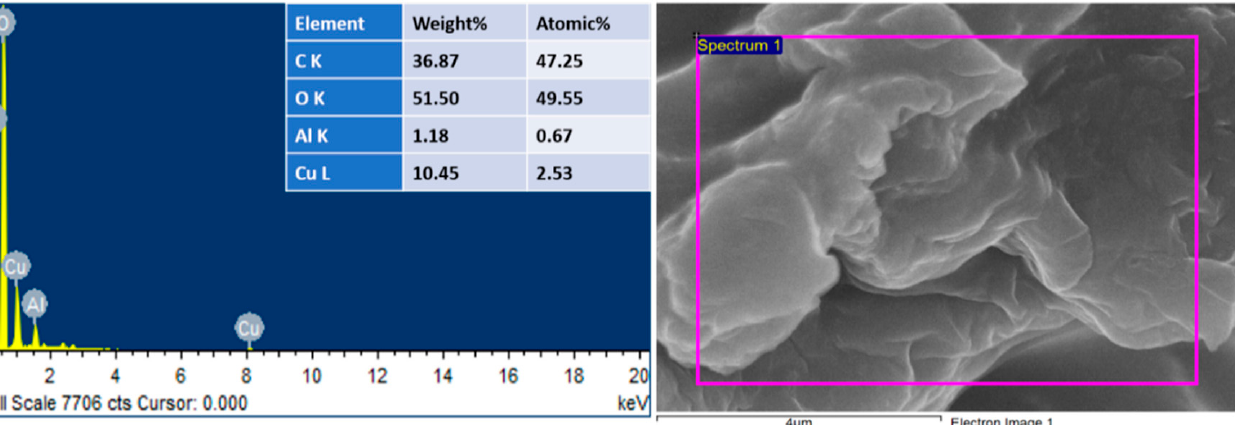
Figure 2. EDS of Cu@Alg/BP nanocatalyst.